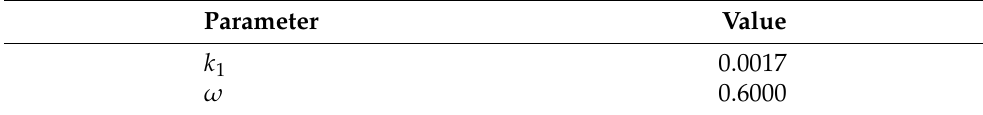
Table 2. Nonlinear concise backstepping controller parameters.